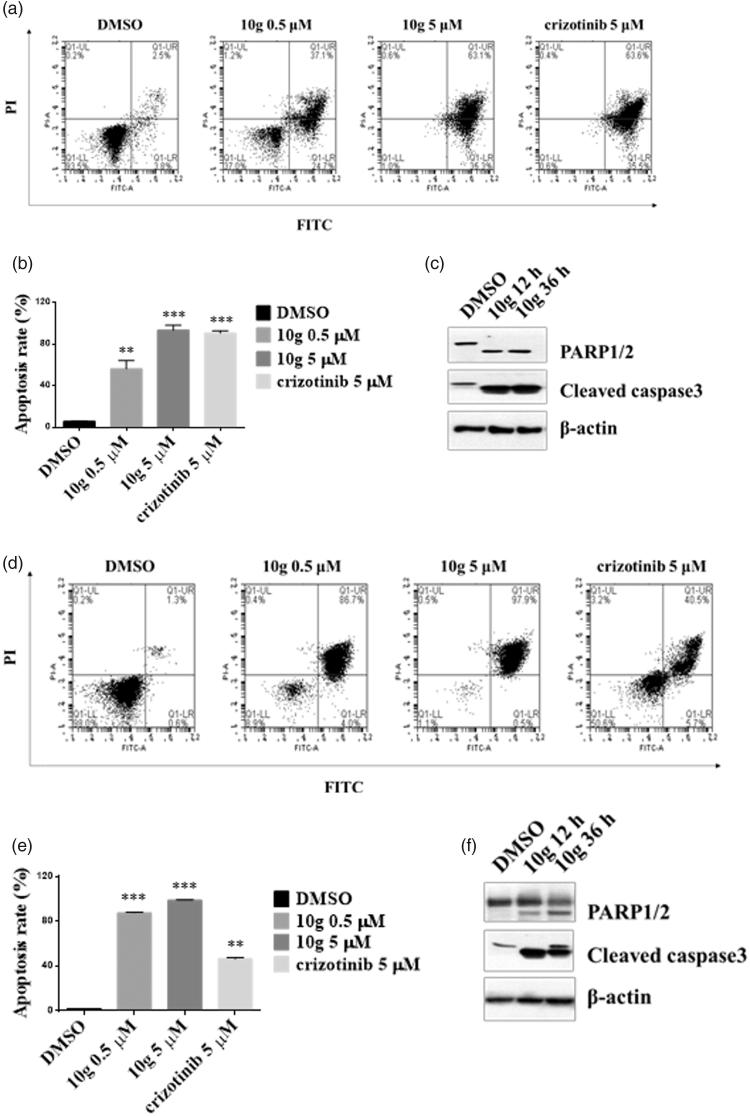
10g induced apoptosis in Ba/F3 cells transformed with ALK-TEL. These cell lines were incubated with 24 h and 48 h, respectively. (a, b) ALK wt-TEL Ba/F3 (d, e) ALK L1196M-TEL Ba/F3 cells were harvested and incubated in a binding buffer containing propidium iodide and annexin V-FITC and then analysed by FACS. t-test **p < .05, ***p < .005. Treatment with 10g for 36 h increased cleaved PARP1/2 and cleaved caspase-3 in Ba/F3 cell transformed with (c) ALK wt-TEL and (f) ALK L1196M-TEL Ba/F3 cells.